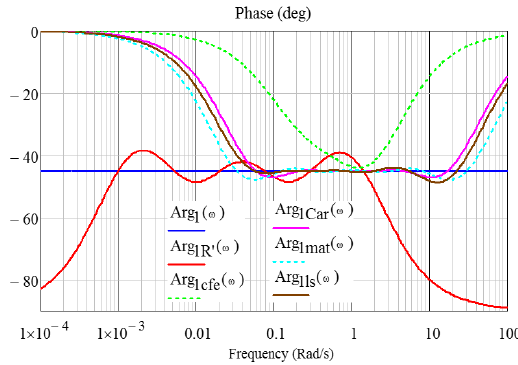
Fig. 4: Errors of the magnitude responses